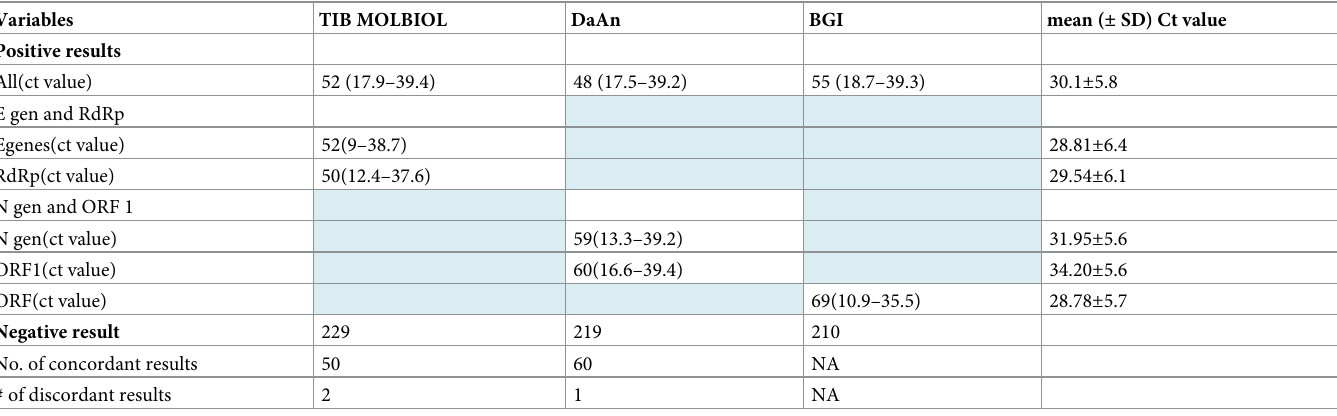
Table 4. Overall results of 279 samples tested by three molecular SARS-CoV-2 detection assays value with corresponding Ct values, Addis Ababa, Ethiopia, 2021.